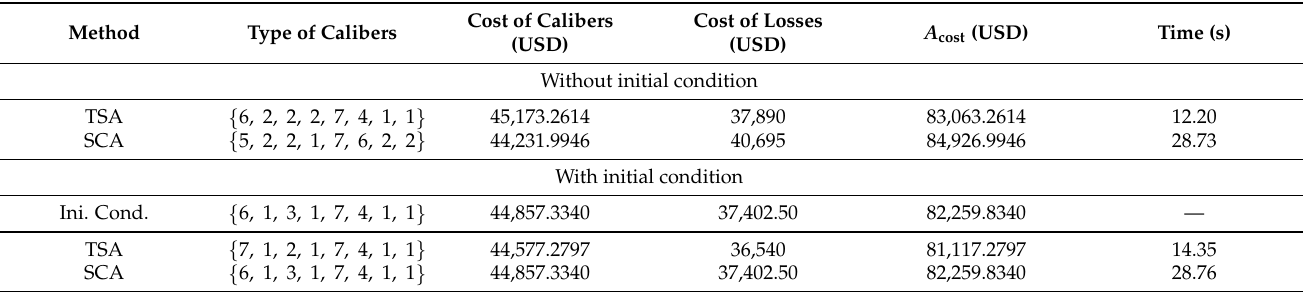
Table 8. Numerical results for the 9-bus system.